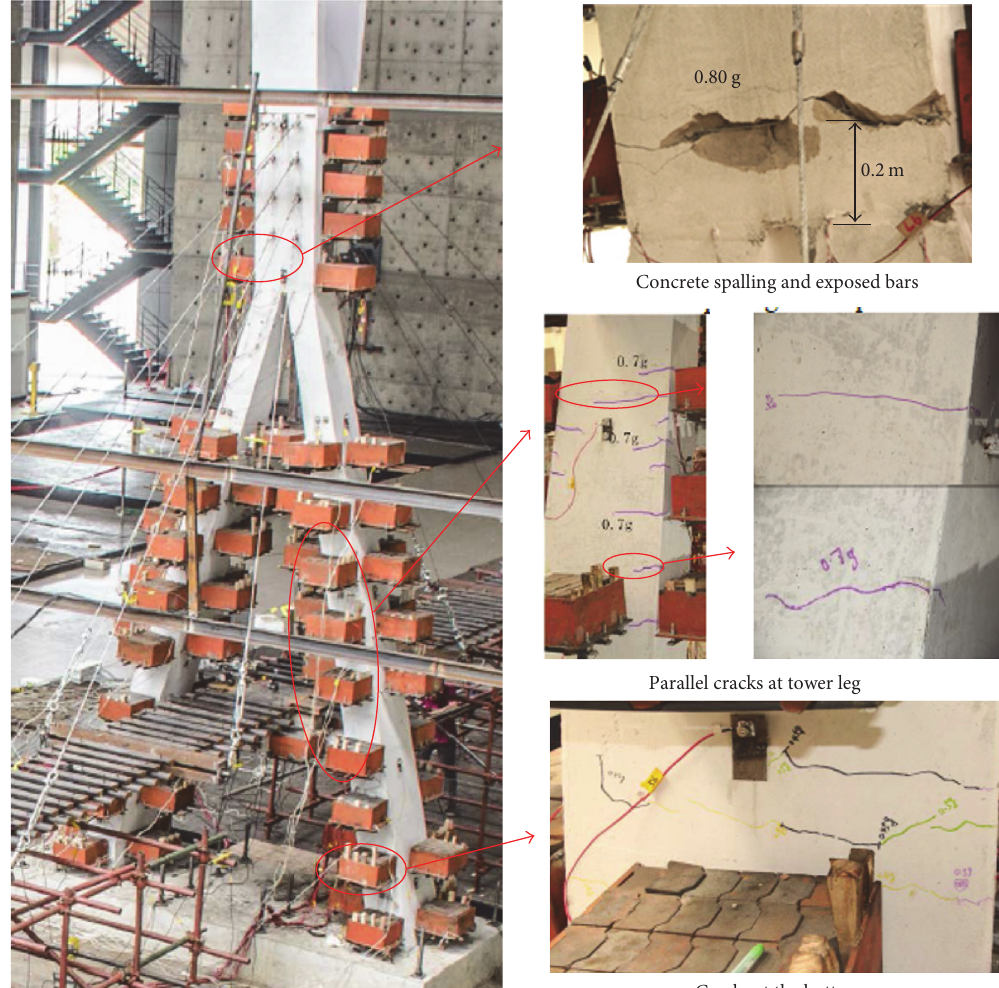
Figure 7: Observed seismic damage of the bridge model.